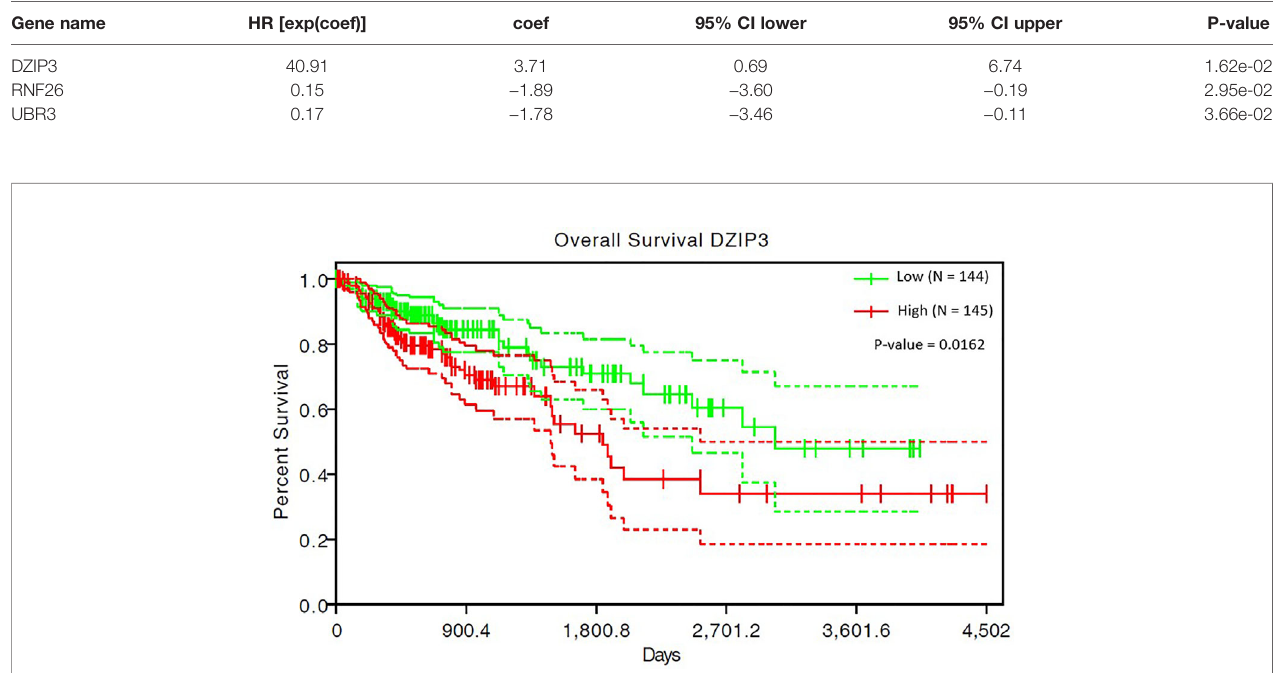
FIGURE 4 | The survival analysis results of COAD patients for DZIP3 .